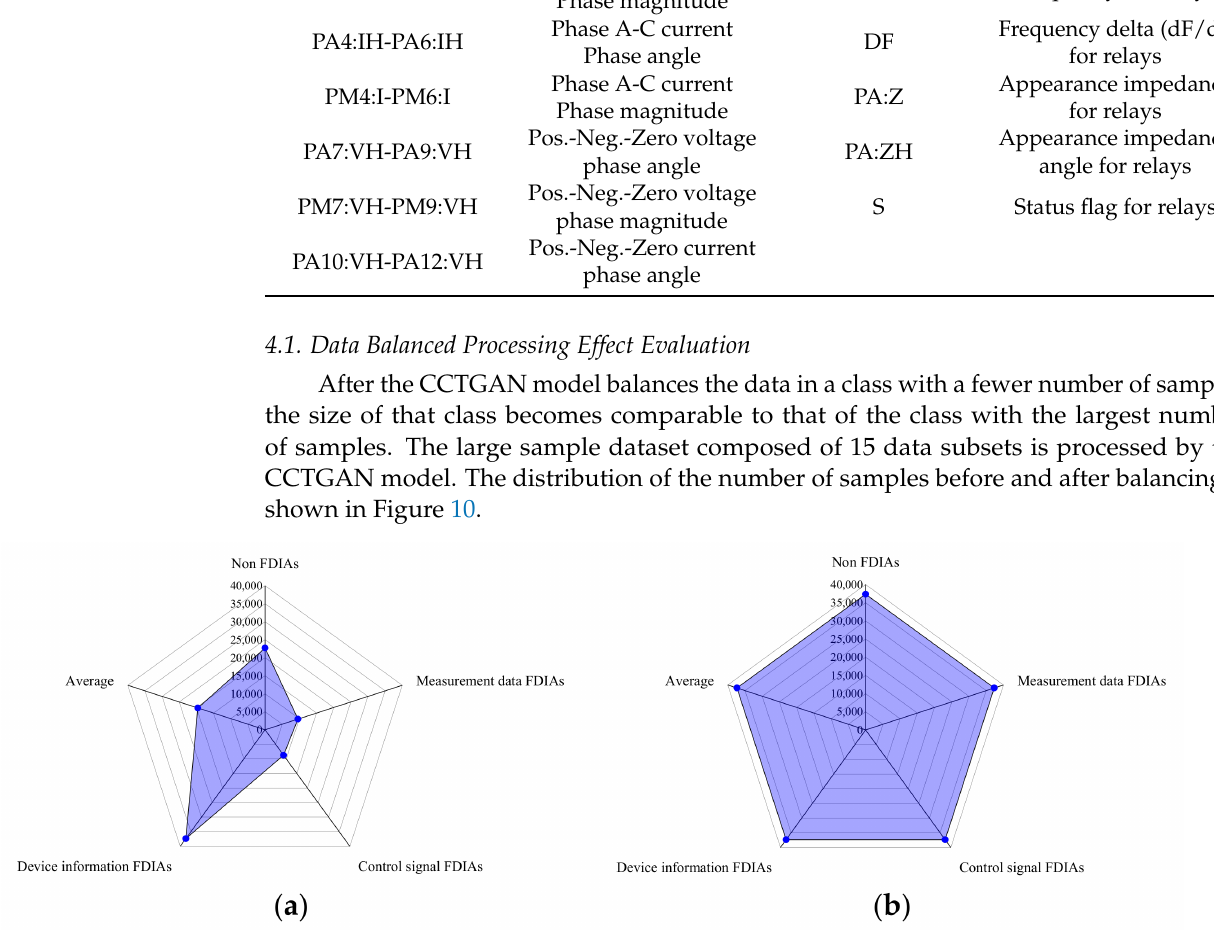
Figure 10. Large sample dataset quantity distribution map before and after data balance processing. ( a ) Before data balance processing; ( b ) after data balance